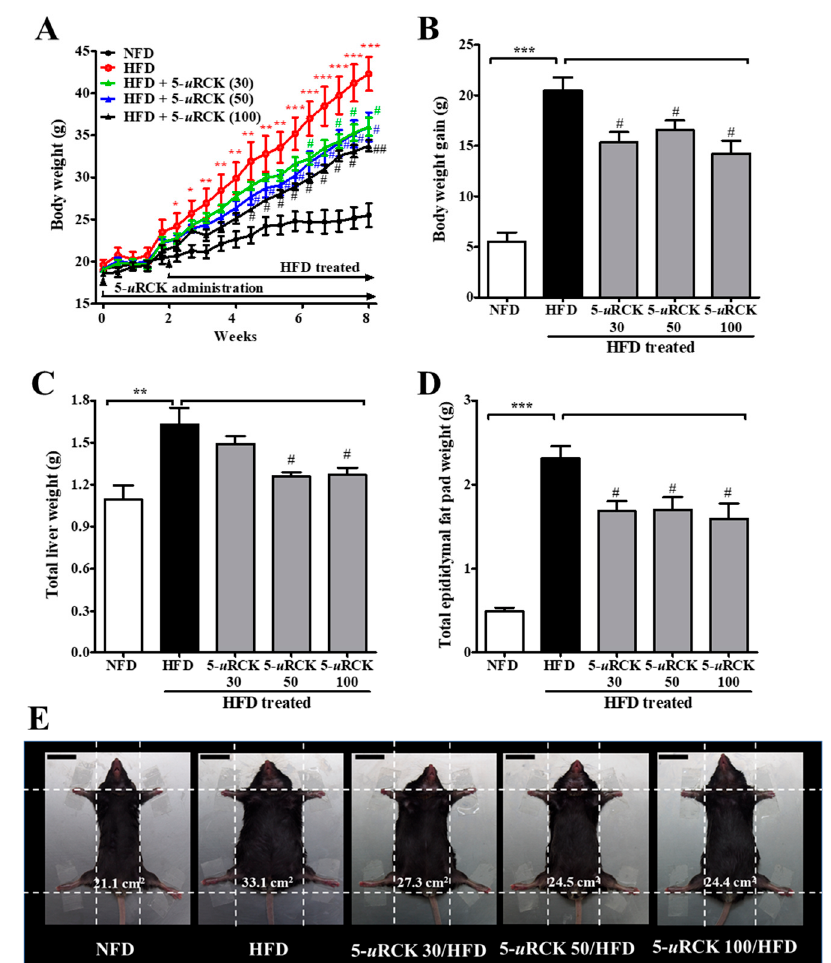
Figure 9. Effect of 5- u RCK on body, liver, and epididymal tissue weight in HFD-induced obese mice. ( A ) Body weight was monitored three times per week for 8 weeks. ( B ) Body weight gain was measured from week 0 until the 8th week. ( C ) The weight of total liver tissue; ( D ) The weight of the epididymal fat pad; ( E ) Phenotype of representative mice from each group. The body width of each group of mice was checked before sacrifice. The scale bars indicate 20 mm. The results are presented as the mean ± SD (n = 8). * p < 0.05, ** p < 0.01 and *** p < 0.001 vs. NFD group; # p < 0.05 and ## p < 0.01 vs. HFD group.